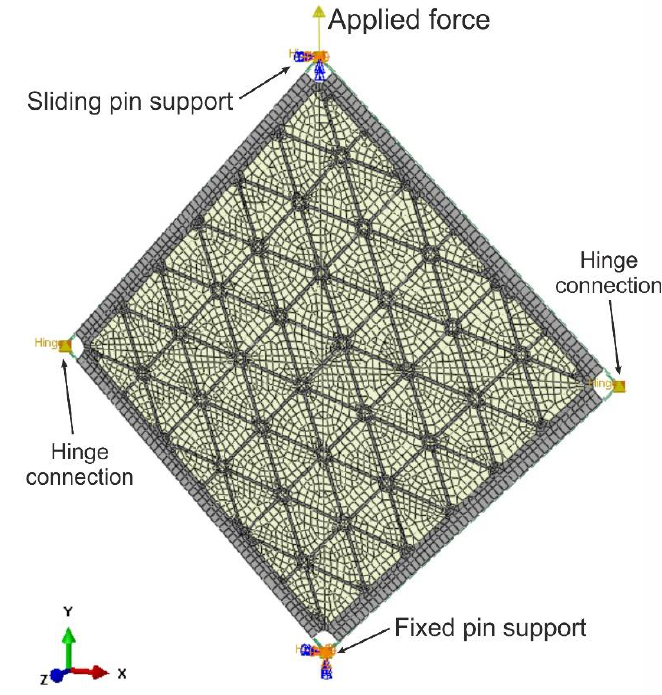
Figure 6. FEM model and boundary conditions.